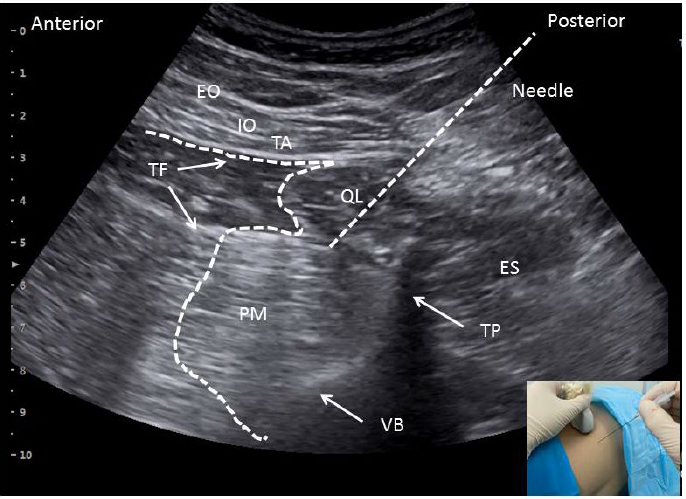
Figure 2. TQLB block under the shamrock sign on the sonogram. TQLB, transmuscular quadratus lumborum block; QL, quadratus lumborum; ES, erector spinae; PM, psoas major; VB, vertebral body; TP, transverse process; TF, transversalis fascia; EO, external oblique abdominis; IO, internal oblique abdominis; TA, transverse abdominis.